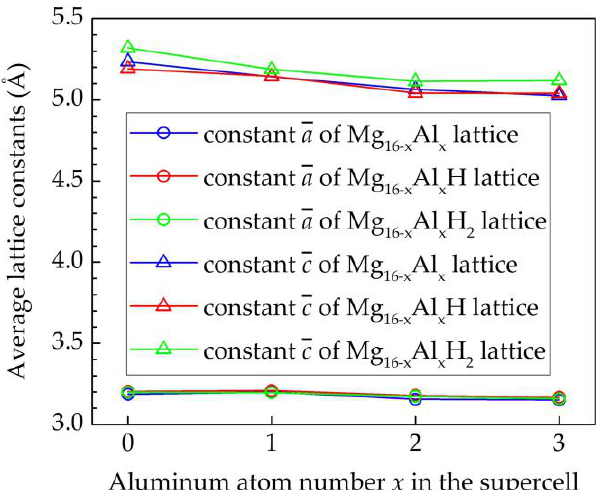
Figure 3. Dependence of the lattice constants of hcp Mg 16 − x Al x H y ( x = 0, 1, 2, 3, y = 0, 1, 2) on Al and H atoms.